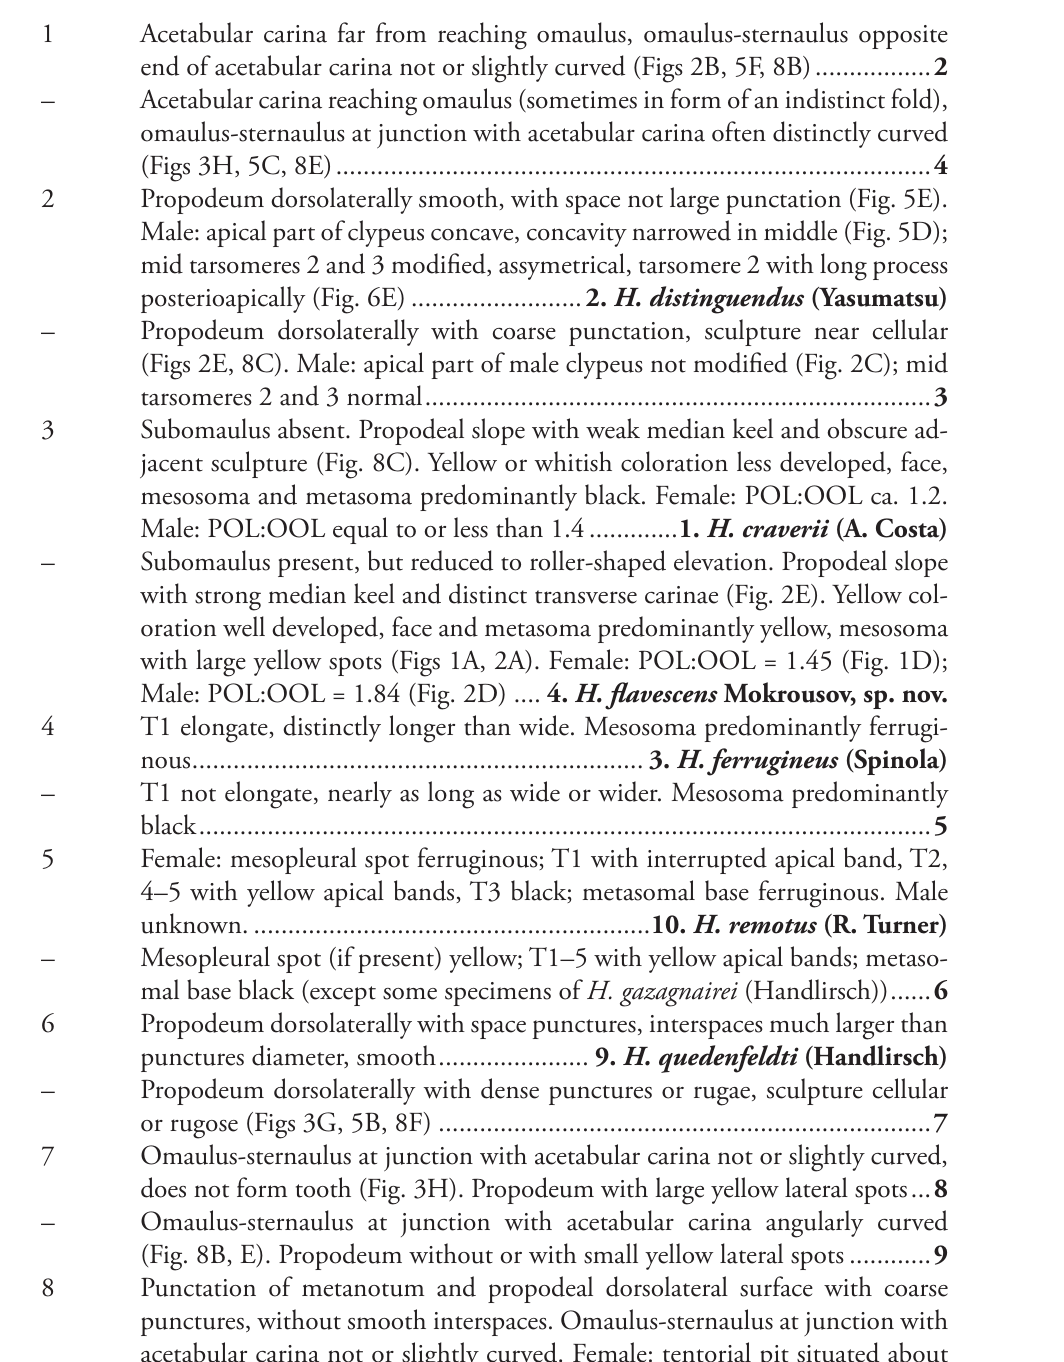
Key to the Palaearctic species of the genus Hoplisoides 1 Acetabular carina far from reaching omaulus, omaulus-sternaulus opposite end of acetabular carina not or slightly curved (Figs 2B, 5F, 8B) ................. 2 – Acetabular carina reaching omaulus (sometimes in form of an indistinct fold), omaulus-sternaulus at junction with acetabular carina often distinctly curved (Figs 3H, 5C, 8E) ....................................................................................... 4 2 Propodeum dorsolaterally smooth, with space not large punctation (Fig. 5E). Male: apical part of clypeus concave, concavity narrowed in middle (Fig. 5D); mid tarsomeres 2 and 3 modified, assymetrical, tarsomere 2 with long process posterioapically (Fig. 6E) ......................... 2. H. distinguendus (Yasumatsu) – Propodeum dorsolaterally with coarse punctation, sculpture near cellular (Figs 2E, 8C). Male: apical part of male clypeus not modified (Fig. 2C); mid tarsomeres 2 and 3 normal .......................................................................... 3 3 Subomaulus absent. Propodeal slope with weak median keel and obscure ad- jacent sculpture (Fig. 8C). Yellow or whitish coloration less developed, face, mesosoma and metasoma predominantly black. Female: POL:OOL ca. 1.2. Male: POL:OOL equal to or less than 1.4 ............. 1. H. craverii (A. Costa) – Subomaulus present, but reduced to roller-shaped elevation. Propodeal slope with strong median keel and distinct transverse carinae (Fig. 2E). Yellow col- oration well developed, face and metasoma predominantly yellow, mesosoma with large yellow spots (Figs 1A, 2A). Female: POL:OOL = 1.45 (Fig. 1D); Male: POL:OOL = 1.84 (Fig. 2D) .... 4. H. flavescens Mokrousov, sp. nov. 4 T1 elongate, distinctly longer than wide. Mesosoma predominantly ferrugi- nous .................................................................. 3. H. ferrugineus (Spinola) – T1 not elongate, nearly as long as wide or wider. Mesosoma predominantly black ........................................................................................................... 5 5 Female: mesopleural spot ferruginous; T1 with interrupted apical band, T2, 4–5 with yellow apical bands, T3 black; metasomal base ferruginous. Male unknown. .......................................................... 10. H. remotus (R. Turner) – Mesopleural spot (if present) yellow; T1–5 with yellow apical bands; metaso- mal base black (except some specimens of H. gazagnairei (Handlirsch)) ...... 6 6 Propodeum dorsolaterally with space punctures, interspaces much larger than punctures diameter, smooth ...................... 9. H. quedenfeldti (Handlirsch) – Propodeum dorsolaterally with dense punctures or rugae, sculpture cellular or rugose (Figs 3G, 5B, 8F) ........................................................................ 7 7 Omaulus-sternaulus at junction with acetabular carina not or slightly curved, does not form tooth (Fig. 3H). Propodeum with large yellow lateral spots ... 8 – Omaulus-sternaulus at junction with acetabular carina angularly curved (Fig. 8B, E). Propodeum without or with small yellow lateral spots ............ 9 8 Punctation of metanotum and propodeal dorsolateral surface with coarse punctures, without smooth interspaces. Omaulus-sternaulus at junction with acetabular carina not or slightly curved. Female: tentorial pit situated